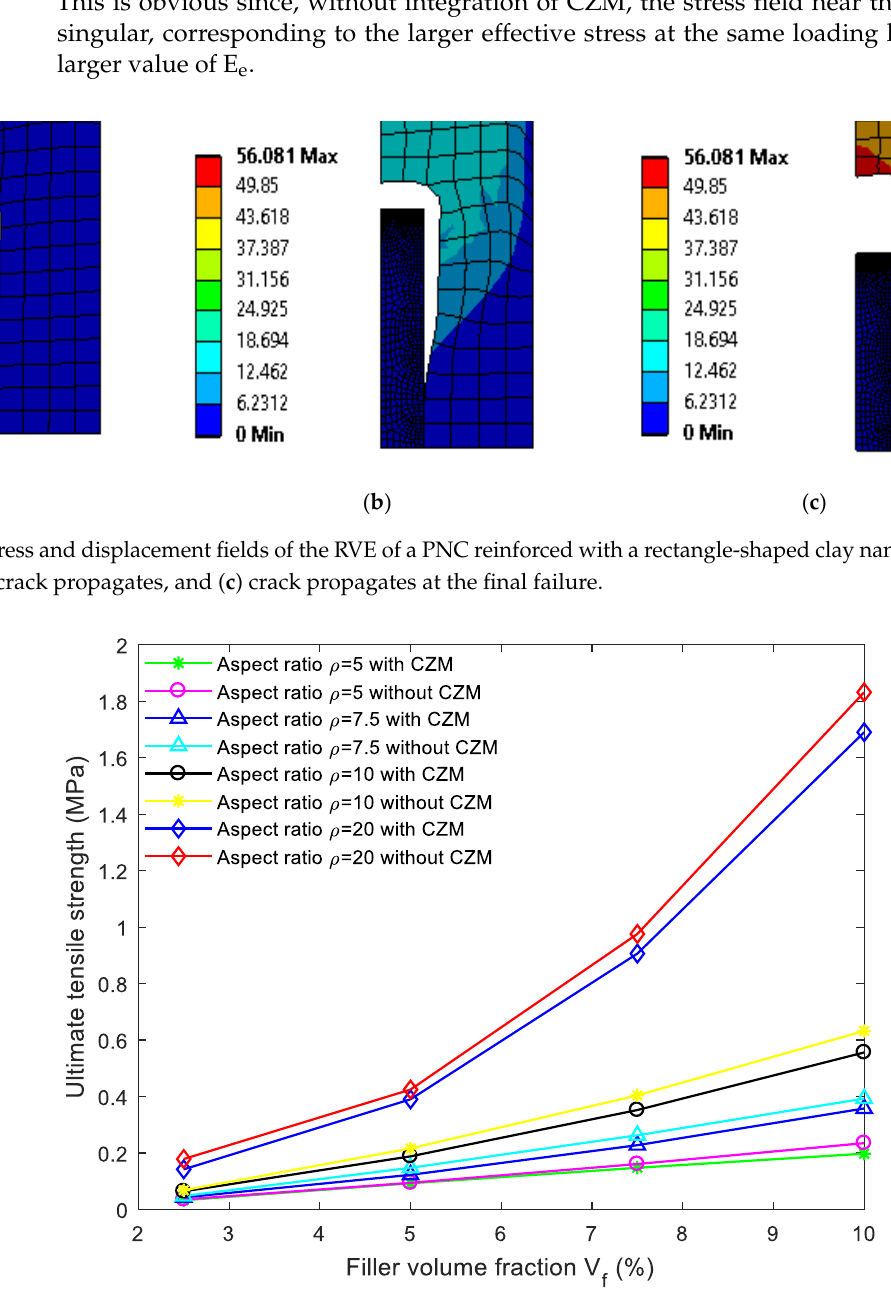
Figure 9. Variations of the effective elastic modulus E e with the clay nanoparticle volume fraction V f at the aspect ratio of ρ = 5, 7.5, 10 , and 20, respectively. Figures 10 – 13 show the reduced effective stress-strain diagrams of the PNCs with varying clay nanoparticle volume fractions (V f = 2.5, 5, 7.5, and 10) and nanoparticle as- pect ratios ( ρ = 5, 7.5, 10 and 20) by FEA integrated with CZM based on the stack clay nanoparticle configuration. In each effective stress-strain diagram, there is a numerically fictitious stress drop in the linearly loading range due to debonding initiation-induced material softening. Such stress dropping phenomenon is decaying with decreasing V f, and nearly no stress dropping is observable at V f = 2.5%. For the purpose of comparison, Figure 14 also shows the effective stress- strain diagrams for ρ = 5 and V f = 2.5, 5, 7.5, and 10 by FEA integrated with CZM based on the stagger clay nanoparticle configuration (Figure 6). It can be found from Figures 10 and 14 that the simulations based on the